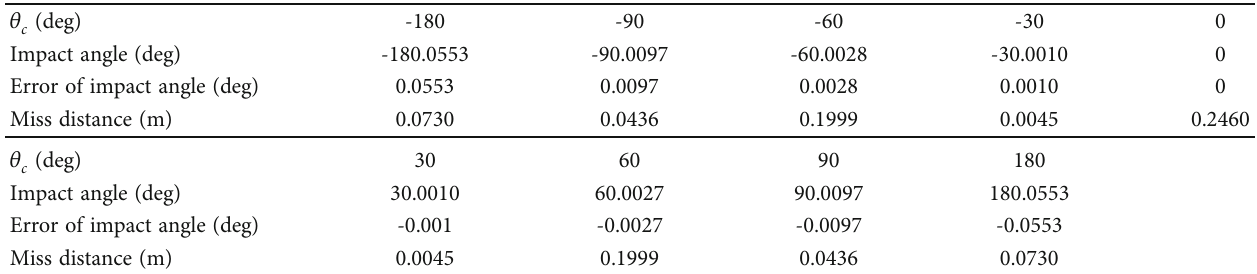
Table 3: Simulation result for Case I.